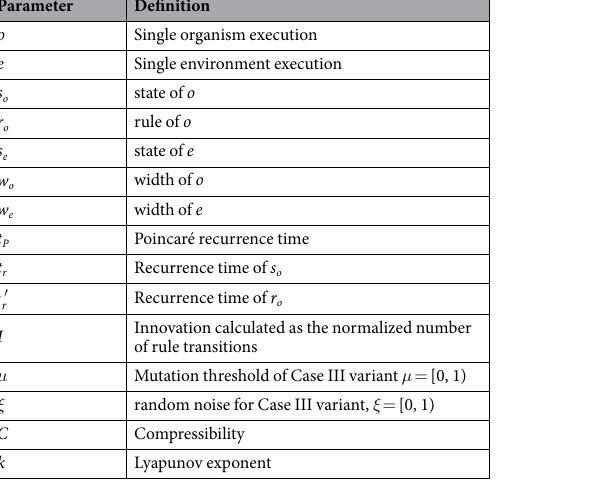
Table 1. Table of terms and model